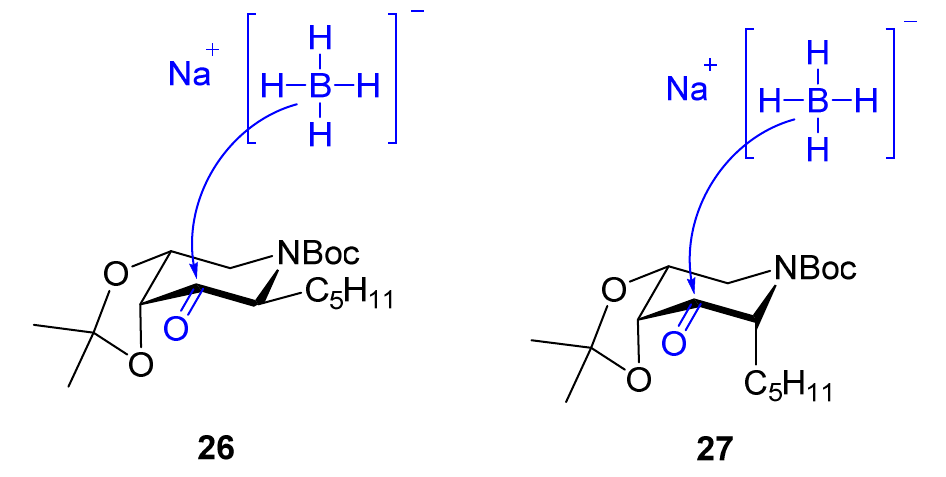
Figure 3. Favored axial attack of hydride to C=O bond. Final removal of the acetonide protecting groups of 28 and 29 under acidic conditions iperidines 11 and 13 as free amines in excellent yields (92% and 98%, Scheme 6). The occurred inversion of configuration at C-3 in compounds 11 and 13 and their preferred conformation were established on the basis of careful analysis of their 1 H-NMR and 1D-NOESY spectra. In particular, for compound 11 , a strong NOE correlation peak between H-3 and H-5 was observed (Figure 4). Together with the high coupling constants observed for the signal of H-3, this finding confirmed an axial orientation of this proton with an ax-ax relationship with H-2 (J = 8.0 Hz) and a 1,3-diaxial interaction with H-5. This pattern agrees with an ( S ) absolute configuration at C-3, with the piperidine displaying a preferred 1 C 4 conformation in which the bulky chain lies in the equatorial